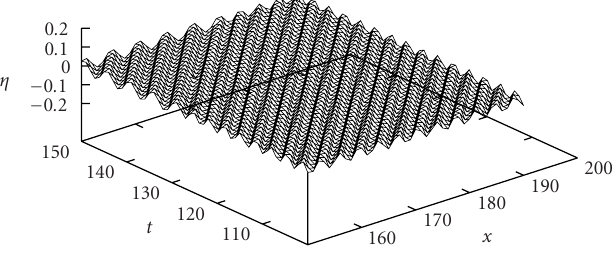
Figure 5.9. Wave motion due to impulse when t = 100 to 150, x = 150 to 200; (cid:1) = 0 . 01, D = 0 . 1.